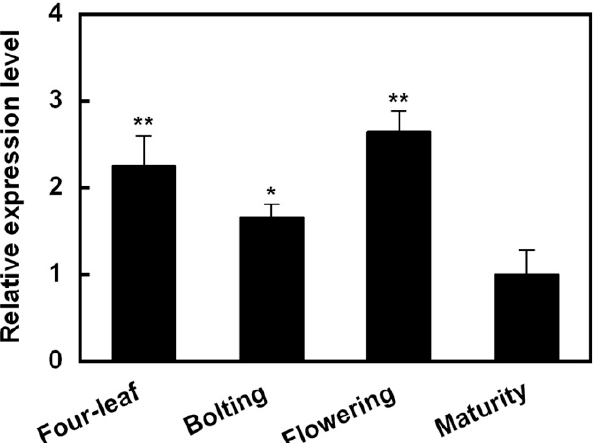
Figure 11. Relative expression of GmPLMT in transgenic Arabidopsis thaliana at different developmental stages. Symbols “*” and “**” indicate significant differences at p values of 0.05 and 0.01, respectively.